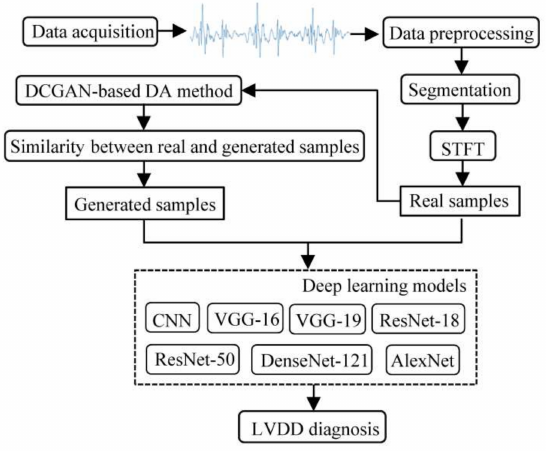
Figure 1. A flow diagram of this paper. The CNN is the proposed model, and the others are the compared models.